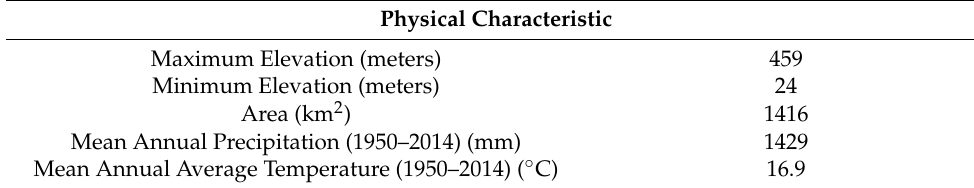
Table 2. Characteristics of the Upper Cahaba River